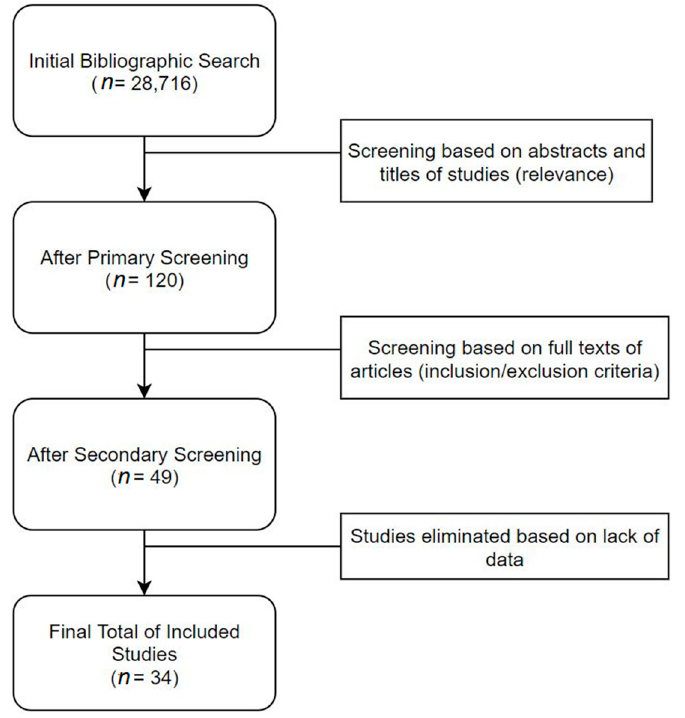
Figure 1. Search